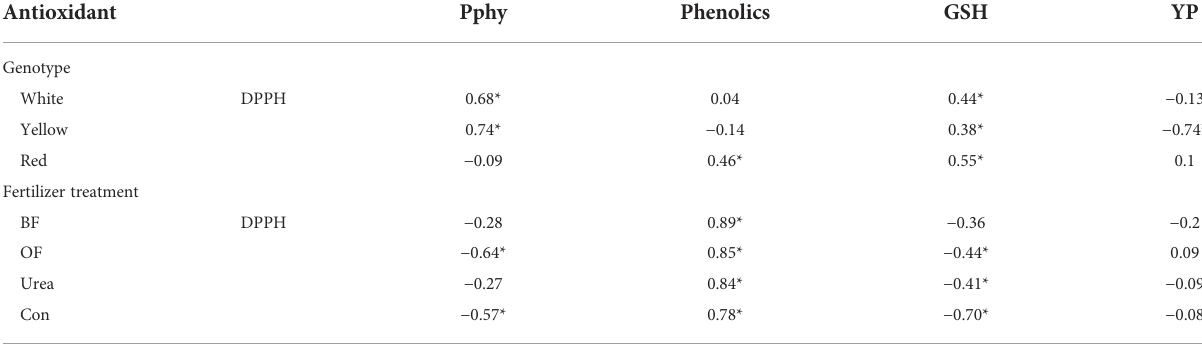
TABLE 7 The correlation between the reduction capacity of the DPPH radical, concentration of the analyzed antioxidants in maize with different kernel colors, and the application of different fertilizers (biofertilizer (BF); organic fertilizer (OF); urea; control (Con; no fertilizer)). Antioxidant